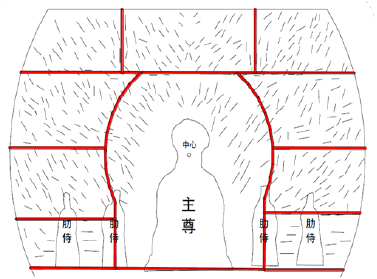
Figure 8. There Are 13 Areas in The Whole Stature